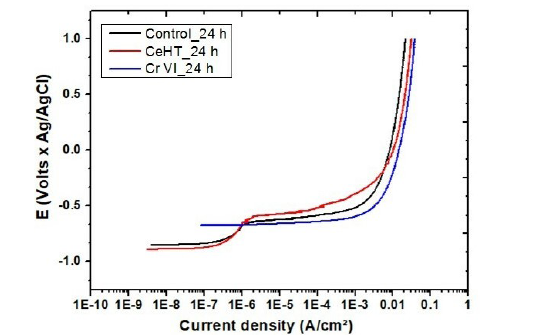
Figure 3. Anodic polarization curves for AA1230 clad on AA2024 alloy with various pre-treatments after 24 h in 0.1 mol L -1 NaCl solution at (23 ± 2) °C and at a scan rate of 0.5 mV s -1